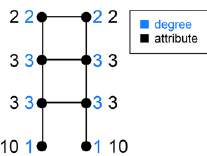
Figure 1. Starting with an SGPF-failing graph such as this, we could grow it by adding nodes so that each new graph still fails SGFP and the degree-attribute correlation approaches